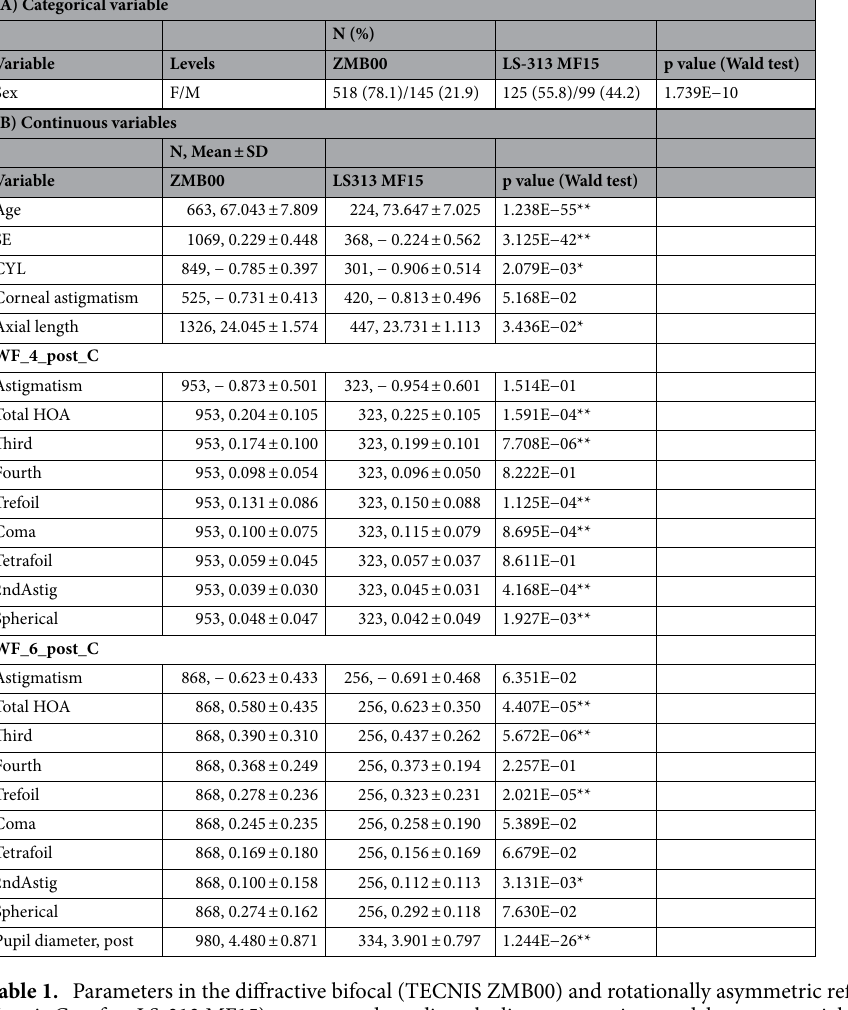
arm length. Therefore, we measured intermediate visual acuity at 50 cm, which was within the reach of most Japanese patients in this study.